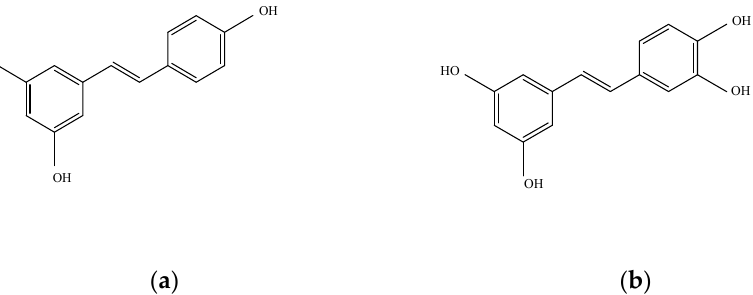
Figure 1. The chemical structure of ( a ) resveratrol (Res) and ( b ) piceatannol (Pic). In the structure formula of Res, two aromatic rings are connected by one methylene double bond. Pic is a hydroxyl derivative of Res.